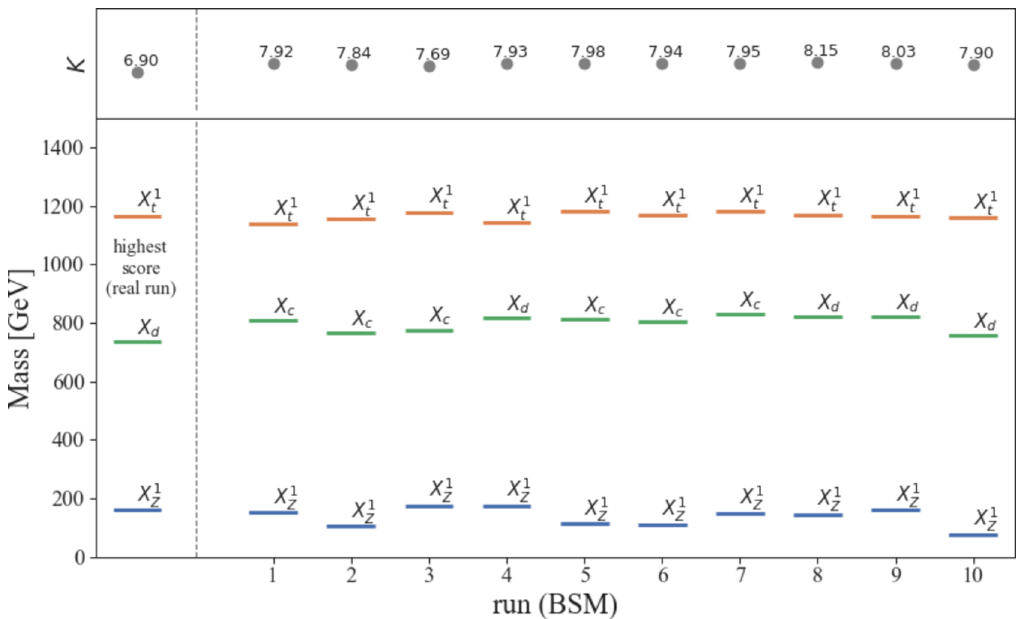
Figure 11 . “Technical” closure test, replacing the observed data with the expected background plus signal yields (without sampling). The spectrum of the proto-model used for the injected signal is shown on the